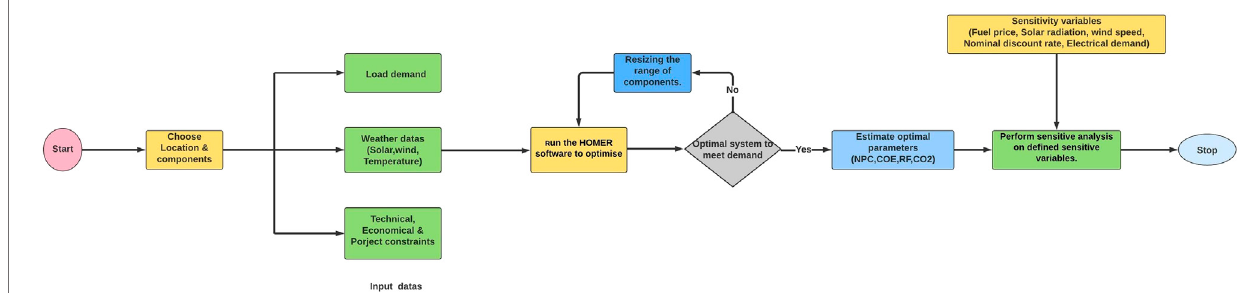
FIGURE 3 | Flowchart of the HOMER optimization algorithm.